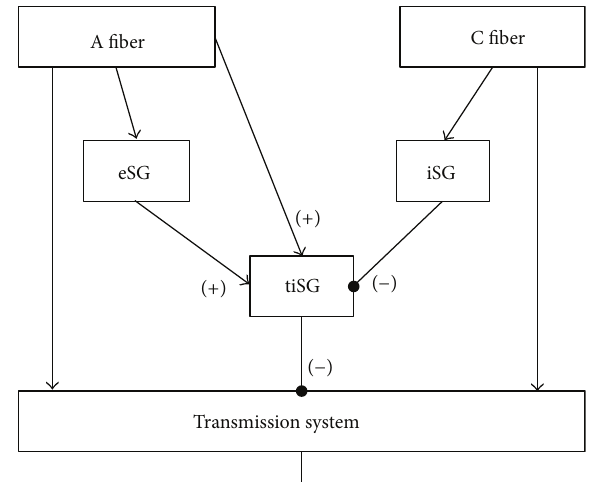
Figure 1: A diagram modified from the gate control theory. Both primary afferent A and C fibers directly target the transmission system that conveys the pain signals from the spinal dorsal horn to the higher brain areas. However, both fibers differentially innervate tothesubstantiagelatinosa(SG)neuronsinthespinalDH.Although polysynaptic inputs are possible in all SG neurons from primary afferent fibers and other SG neurons, monosynaptic inputs from A fibers reach the excitatory SG neurons (eSG) and the transmission- inhibiting SG neurons (tiSG), while those from C fibers only go into the inhibitory SG neurons (iSG), not the itSG directly. The tiSG neurons receive the excitatory synaptic inputs from the eSG and the inhibitorysynaptic inputsfromtheiSG. Themain function oftiSG is inhibiting the transmission system, both presynaptically (in the gate control theory) and postsynaptically (in this diagram). In this way, the activation and inhibition of SG neurons (here, called tiSG) by large-diameter and small-diameter fibers, respectively, are possible, shown in the gate control